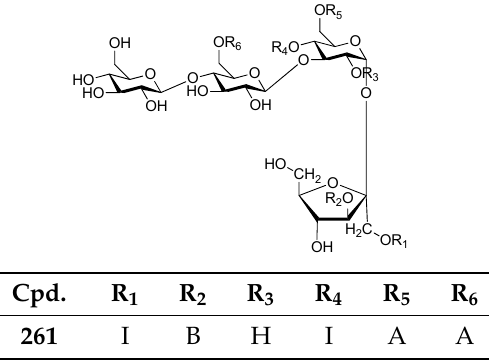
Figure 56. Structure of compound 261 .